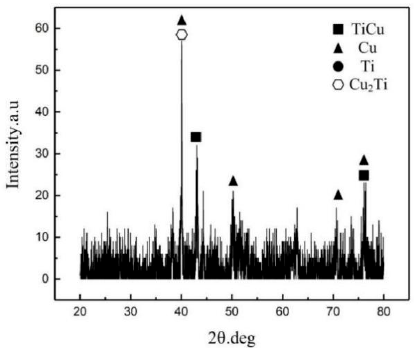
Figure 22. XRD analysis results of fracture surfaces for 301L/Cu/TA2 welded joints.